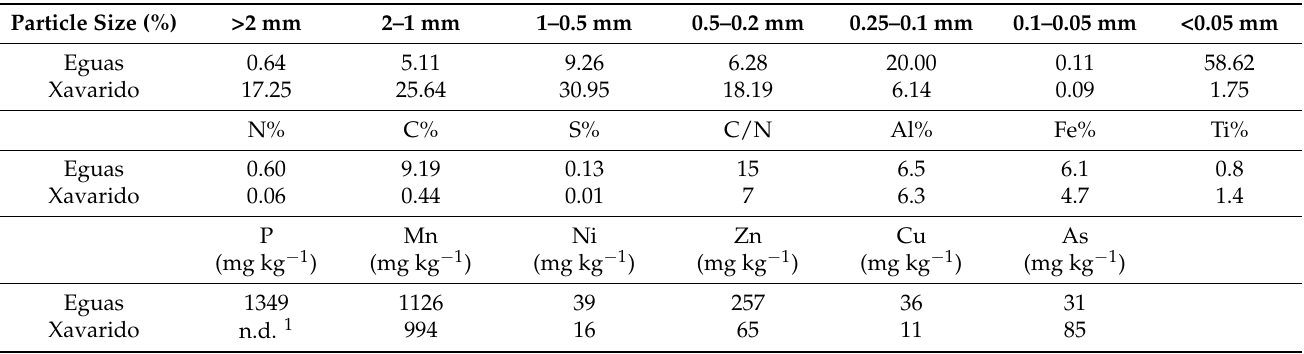
Table 2. Characterization of Anll ó ns River